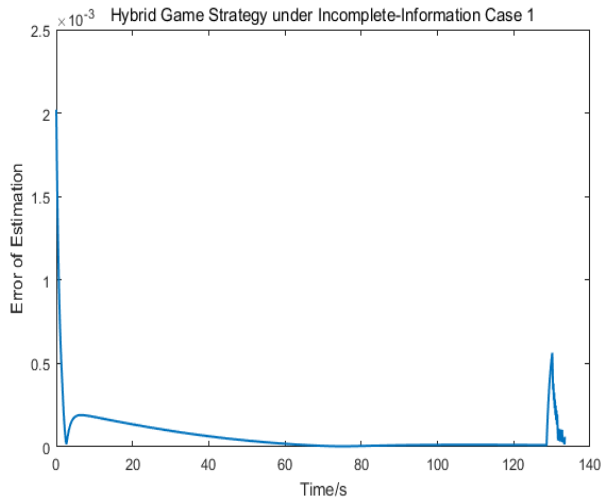
Figure 7. Error estimation of U E .